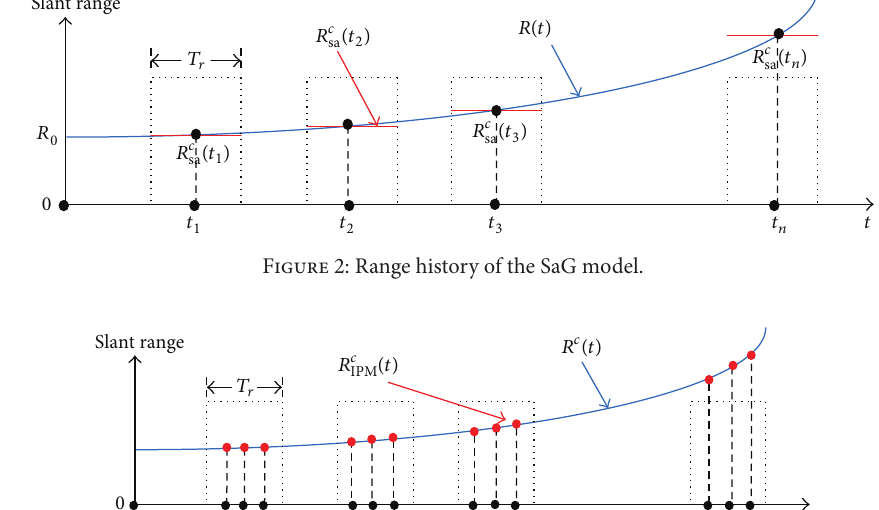
Figure 3: Range history of the IPM model.